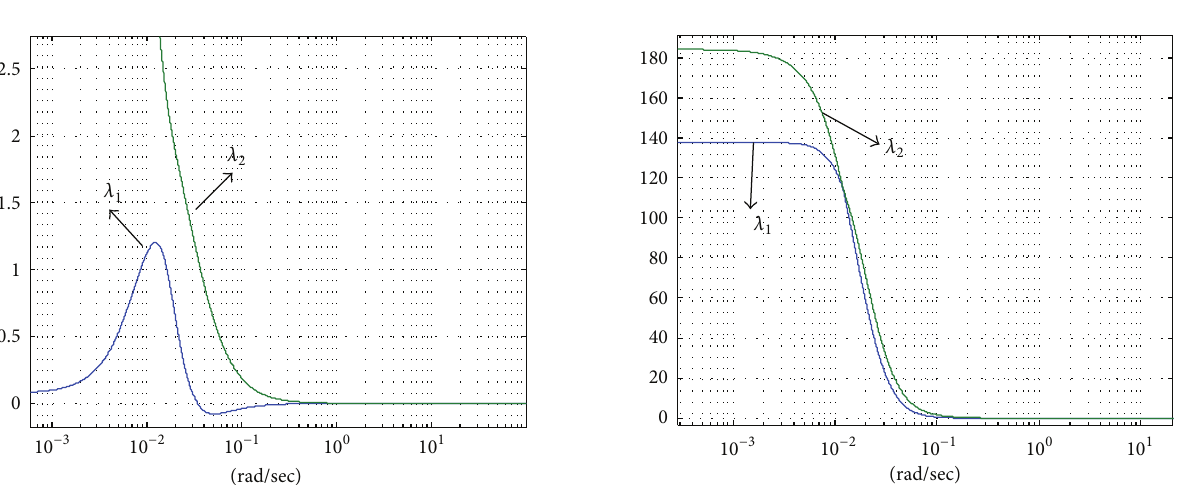
Figure 3: Eigenvalues of [𝐺 2 (𝑗𝜔) + 𝐺 ∗ 2 (𝑗𝜔)] (Case 2 ).